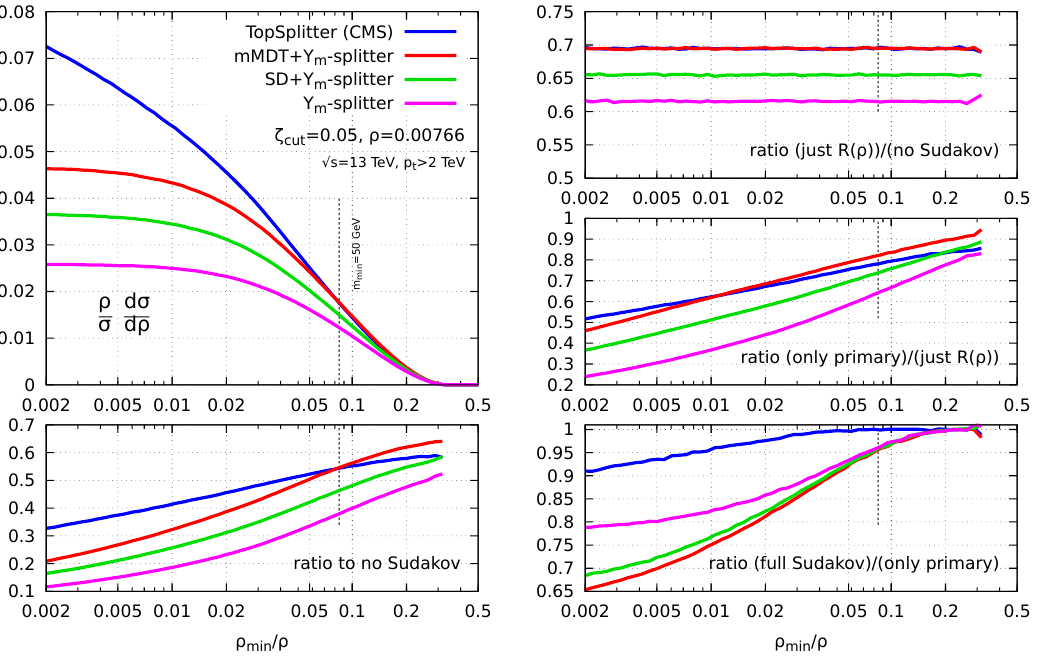
Figure 5. Study of the resummation e(cid:11)ects for the various taggers as a function of (cid:26) min . The top-left plot shows the distribution (cid:26)=(cid:27)d(cid:27)=d(cid:26) , and the bottom-left plot shows the overall Sudakov e(cid:11)ect (the ratio of (cid:26)=(cid:27)d(cid:27)=d(cid:26) with and without the Sudakov form factor). On the right, di(cid:11)erent levels of approximation to the Sudakov were made: (top) simply using the jet-mass Sudakov (plain, SD or mMDT depending on the tagger) down to the scale (cid:26) , (middle) considering instead the full Sudakov from primary emissions, and (bottom) adding secondary emissions. Each plot shows the ratio to the previous